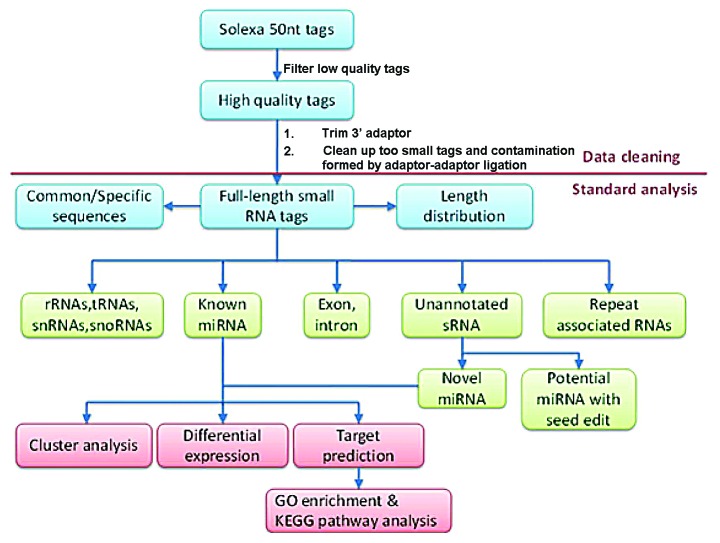
MicroRNA (miRNA) microarray analysis process. The data analysis process used 50 nucleotide tags that were produced by high-throughput sequencing. The low quality reads were filtered out in accordance with the base quality value. The adaptor sequence was trimmed at the 3′-terminus. The 5′ adaptor contaminants that were formed by ligation were removed. The clean, high-quality reads were used for standard analysis. Cluster analysis contained the data on small RNA expression and distribution in each genome. Differential expression included miRNA and novel miRNA expression in the membranous nephropathy (MN) and normal control (NC) groups. Target prediction was analyzed using the summary of known miRNA alignments and miRNA base edits. rRNA, ribosomal RNA; tRNA, transfer RNA; snRNA, small nuclear RNA; snoRNA, small nucleolar RNA; sRNA, small RNA.